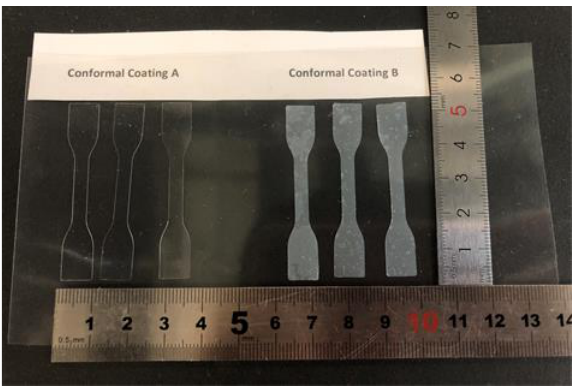
Figure 2. Silicone conformal coating A and B dog bone for tensile test.